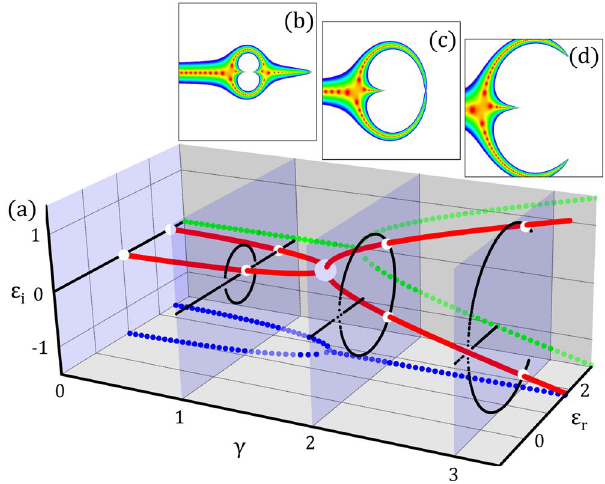
Figure 3. ( a ) Evolution of two selected eigenenergies connected via EP in a CS lattice with N = 100 unit cells. As γ increases, two real eigenenergies (solid red lines) coalesce at an EP (large gray dot), and then split into two complex conjugate eigenenergies from the EP. The two projected figures show the real (blue dotted) and imaginary (green dotted) parts of the complex eigenenergies as a function of γ . All eigenenergies on the complex planes are shown, which correspond to the complex energy band structures (black dots on the blue panels) in Fig. 1 with corresponding γ . ( b – d ) Transmission probabilities on the complex incident energy plane reflecting complex eigenenergies. The red region represents high transmission probability corresponding to the resonant states as in Fig.